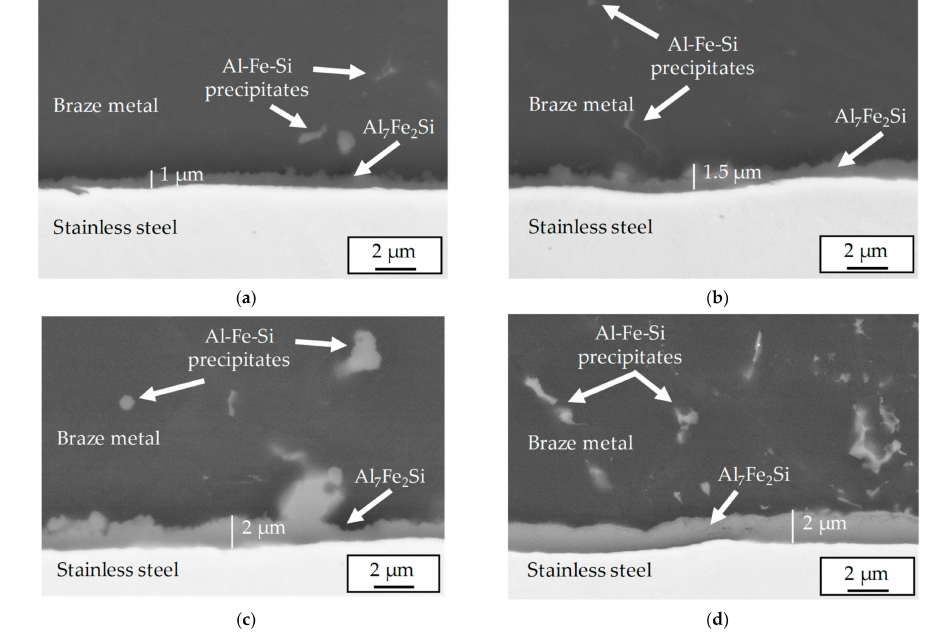
Figure 2. SEM images of the reaction zones after brazing ( a ) and after long-term thermal exposure experiments at a temperature of 200 ◦ C for 6 h ( b ), for 48 h ( c ) and for 120 h ( d